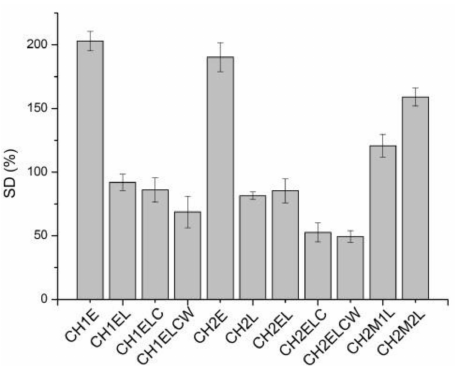
Figure 2. Swelling degree (SD) for chitosan/starch-based samples.